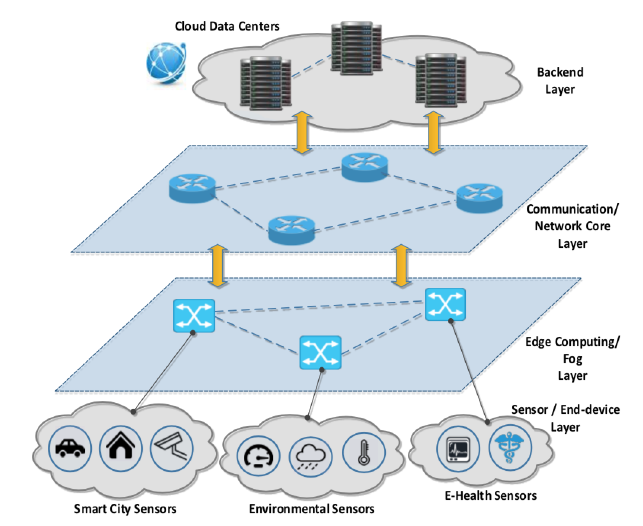
Figure 2. Introducing fog computing in the communication stack